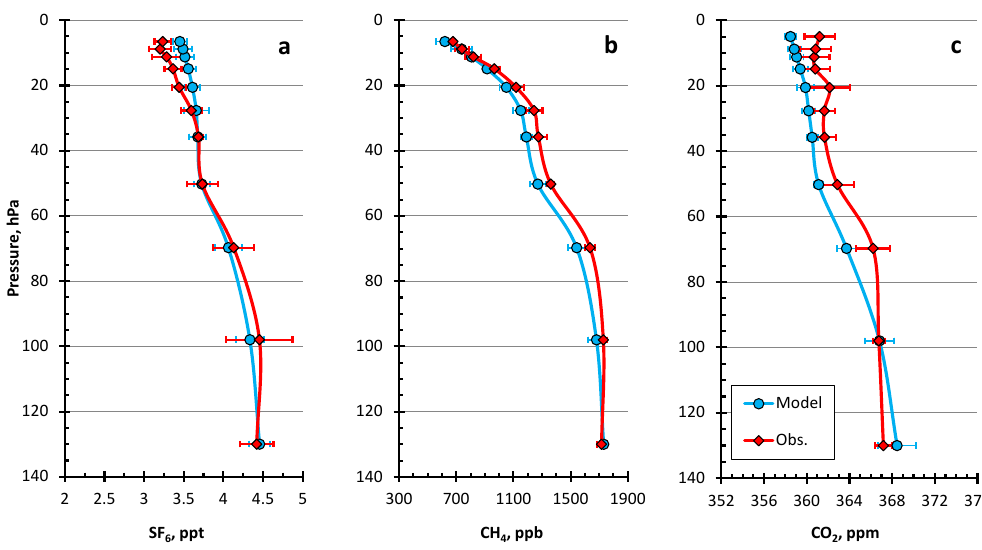
Fig. 4. Comparison of observed and modelled concentration averaged for the period 2000–2007: (a) SF 6 , (b) CH 4 , and (c) CO 2 . The observed VMRs were derived from six individual profiles of balloon-borne measurements over Sanriku, Japan (39.17 ◦ N, 141.83 ◦ E).